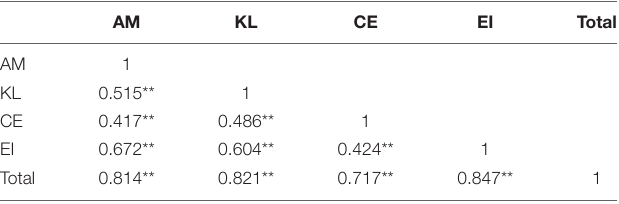
TABLE 6 | Correlation coefficients of potential